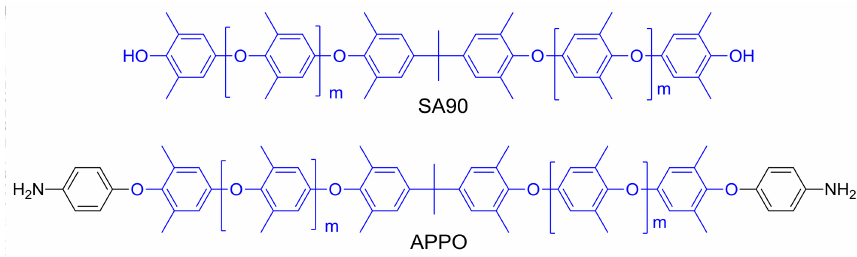
Figure 1. Structures SA90 and APPO. Note that there are no free ortho for